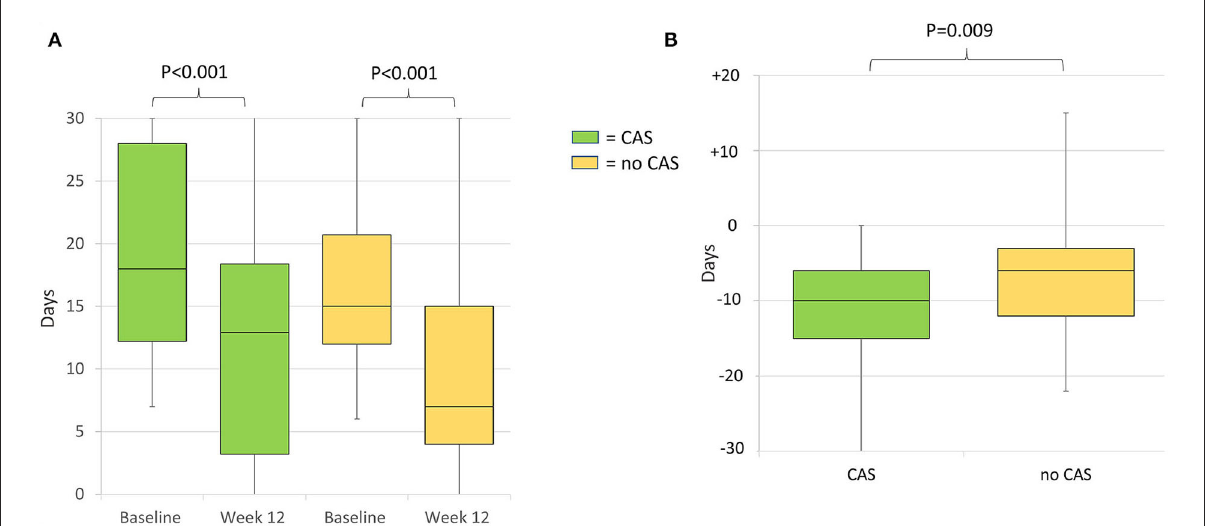
FIGURE4 (A) Median monthly headache days at baseline and week 12 of treatment of patients with and without cranial autonomic symptoms. Baseline monthly headache days did not differ between the groups ( P = 0.108). (B) Median difference in monthly headache days from baseline to week 12 in patients with and without cranial autonomic symptoms. CAS, Cranial Autonomic